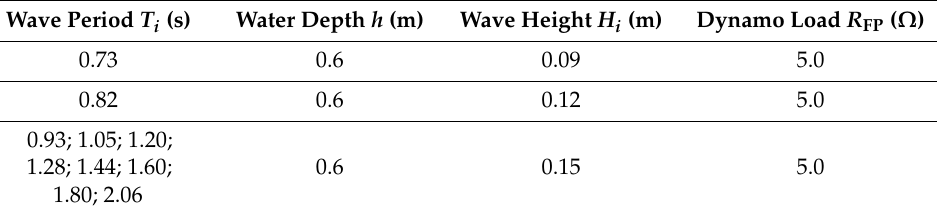
Table 2. Cases of experiment series